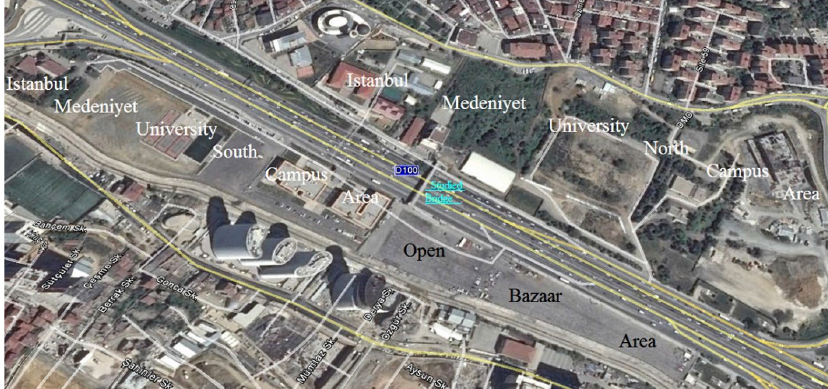
Figure 1. Location of the studied bridge